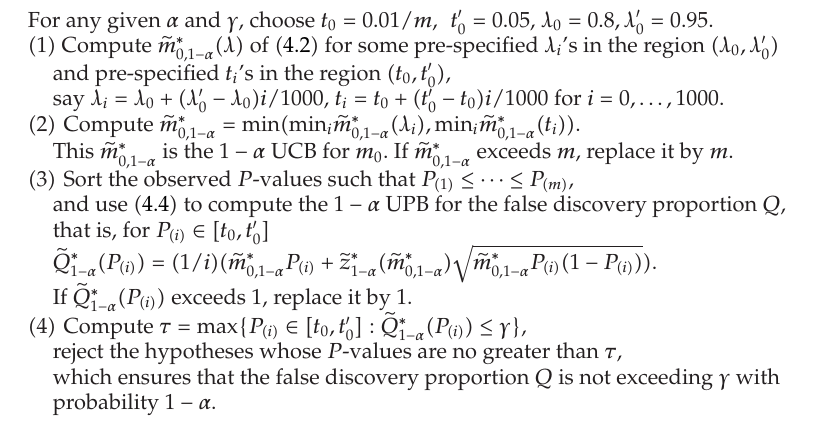
(cid:4) 0 . 05, λ (cid:4) 0 . 8 ,λ (cid:5) (cid:4) 0 . 95. 0 0 0